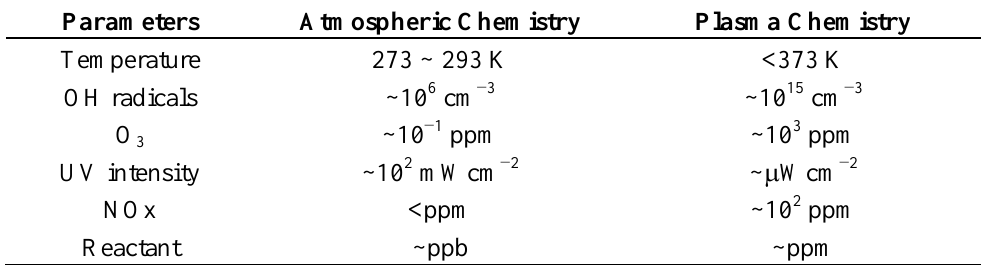
Table 1. Typical parameters in atmospheric chemistry and plasma chemistry (in